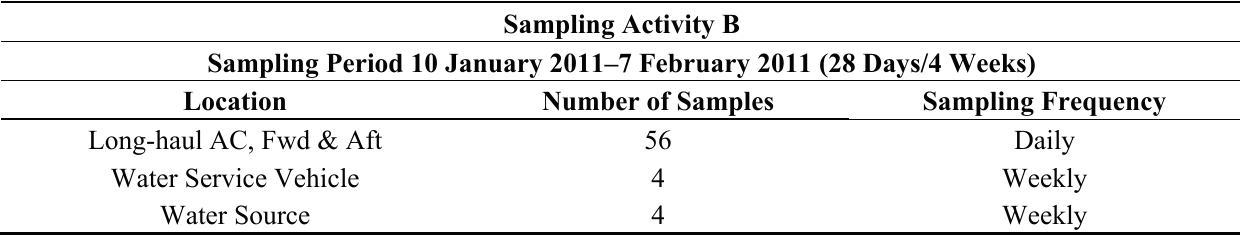
Table 3. Water Sampling Activity B/Location, Number of Samples and Sampling